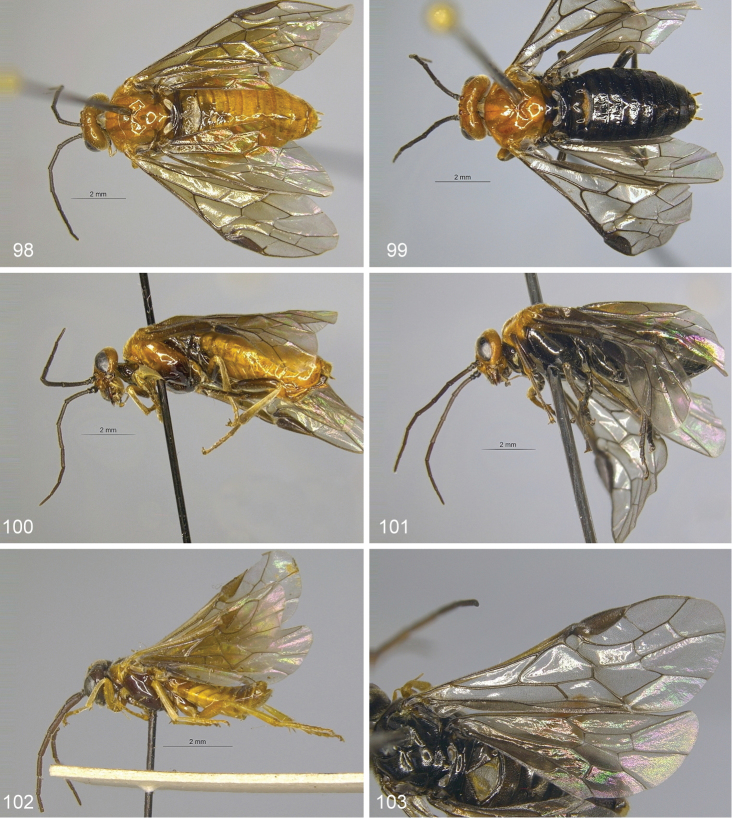
Hemichroa98–100crocea DEI-GISHym19402 ♀, Germany, Mecklenburg-Vorpommern 99, 101australis DEI-GISHym15401 ♀, Sweden, Torne Lappmark 102crocea DEI-GISHym31838 ♂, Germany, Mecklenburg-Vorpommern 103australis DEI-GISHym20618 ♂, Sweden, Torne Lappmark, fore wing. Scale bar: 2 mm.